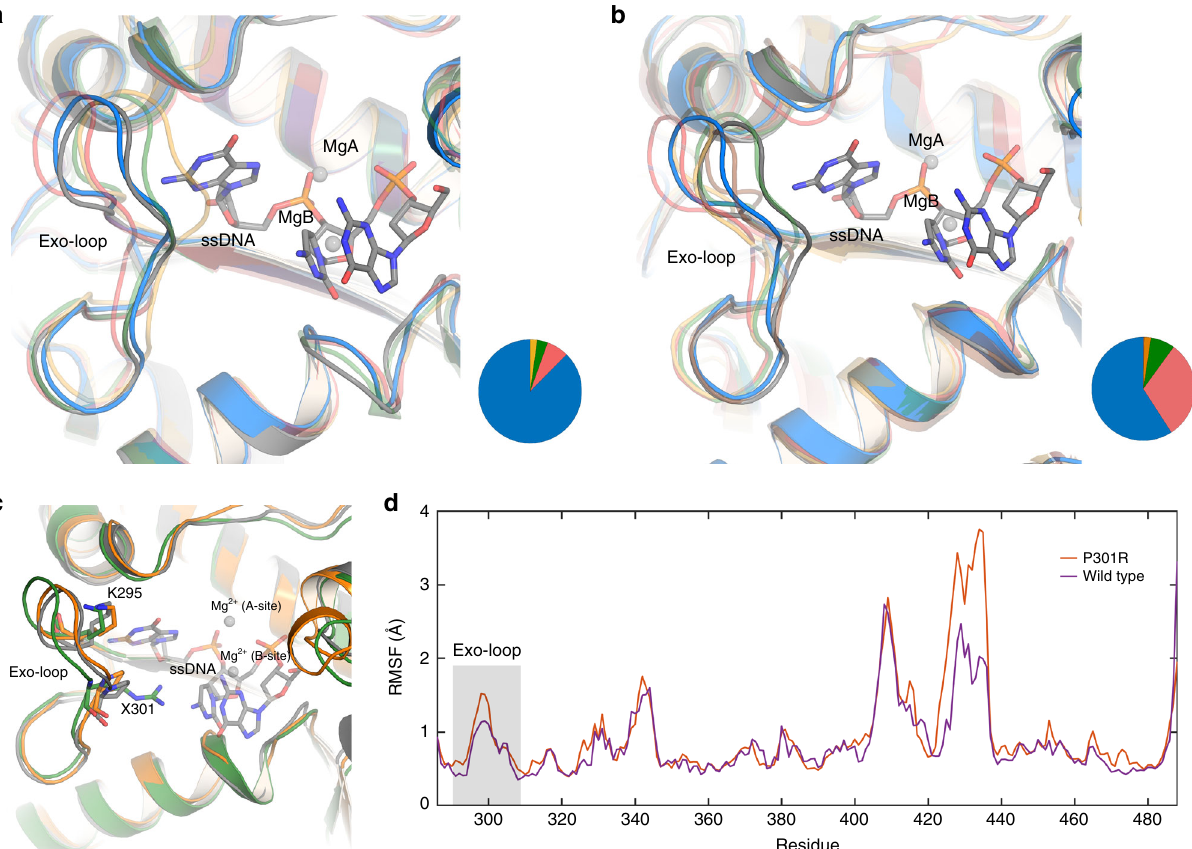
Fig. 5 A comparison of different representative clusters of the Exo-loop during 3 × 200 ns simulations of wild-type and P301R forms of the exonuclease domain of Pol ε . The structures of ( a ) wild-type and ( b ) P301R were obtained by performing average-linkage clustering with a sieve value of 5 and a cutoff distance of 2.0 Å. Shown here are the centroids from each cluster, illustrating the greater conformational variability of the Exo-loop in the P301R mutant. The pie charts denote the relative population of each cluster, and have been color matched to the different structures shown in the overlay panels ( a , b ). The actual corresponding cluster occupancies are shown in Supplementary Table 1. The starting structure based on the crystal structure and ssDNA and metals from RB69 gp43 (PDB ID: 1clq [https://www.rcsb.org/structure/1clq]) used for simulations is depicted in gray color. c An overlay of the centroid